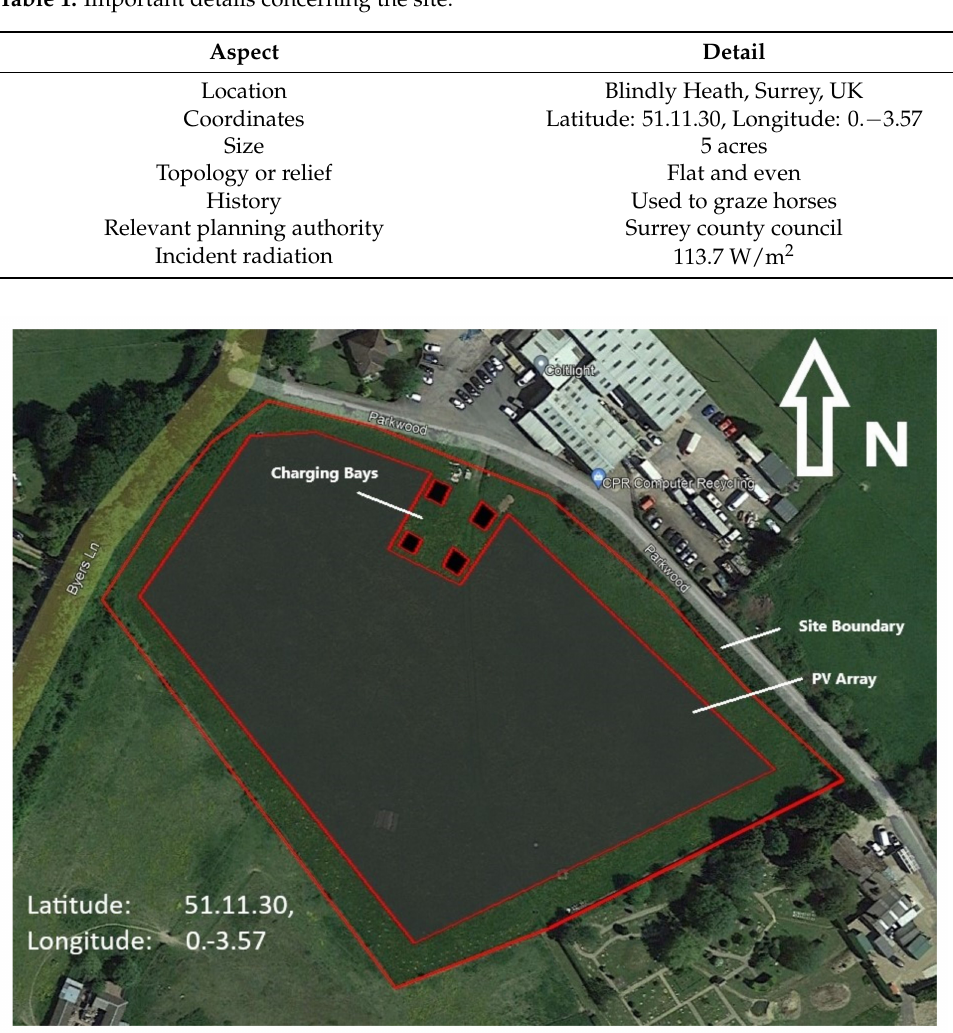
Table 1. Important details concerning the site.